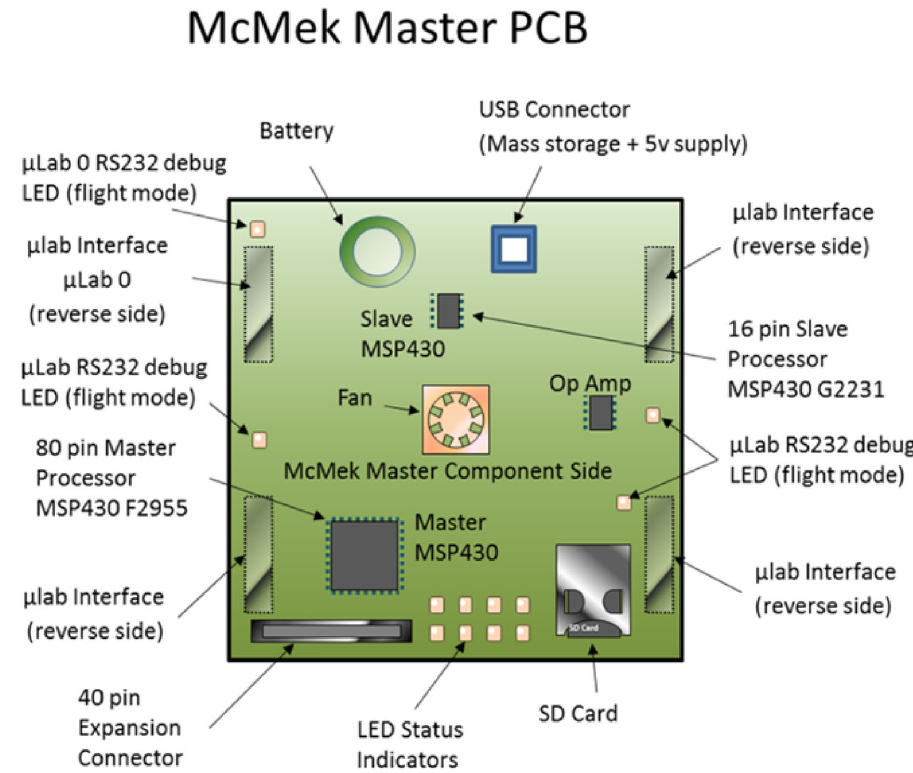
Fig. 2 McMek master control board inside the NanoLab communication fl ow